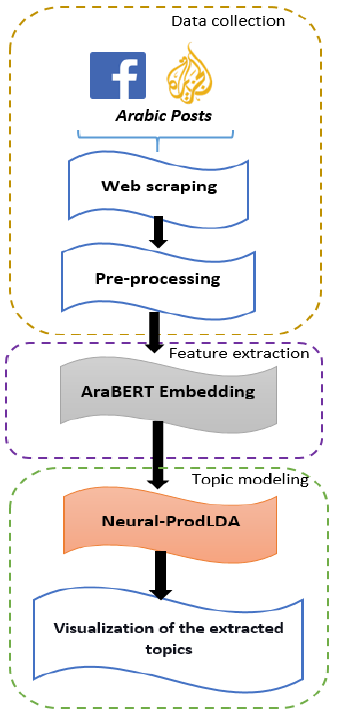
Figure 1 . Flow Diagram of proposed approach.